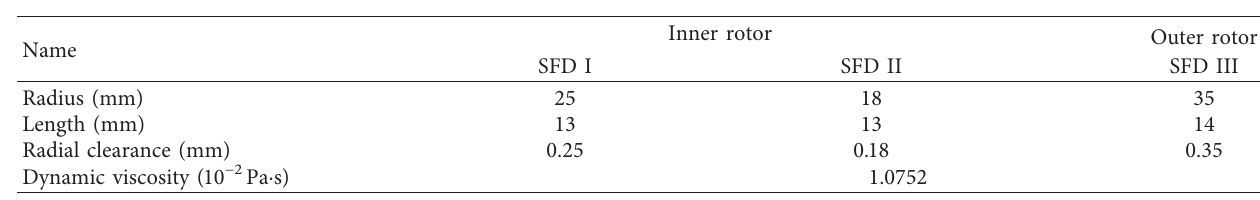
Table 4: Parameters of